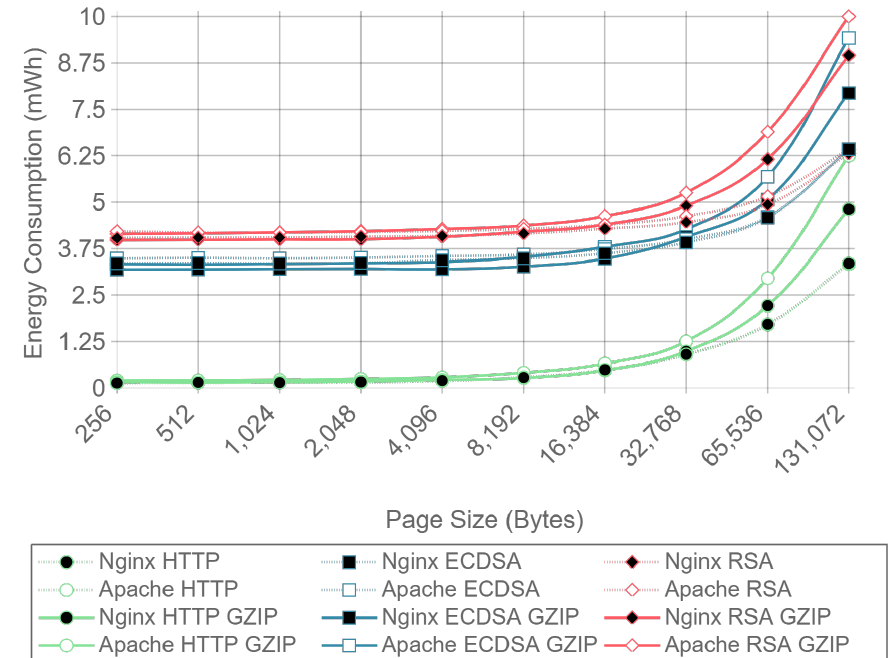
Figure 9. Client-side page size versus energy consumption for Apache2 and Nginx with 16 concurrent clients, with and without GNU ZIP (GZIP)